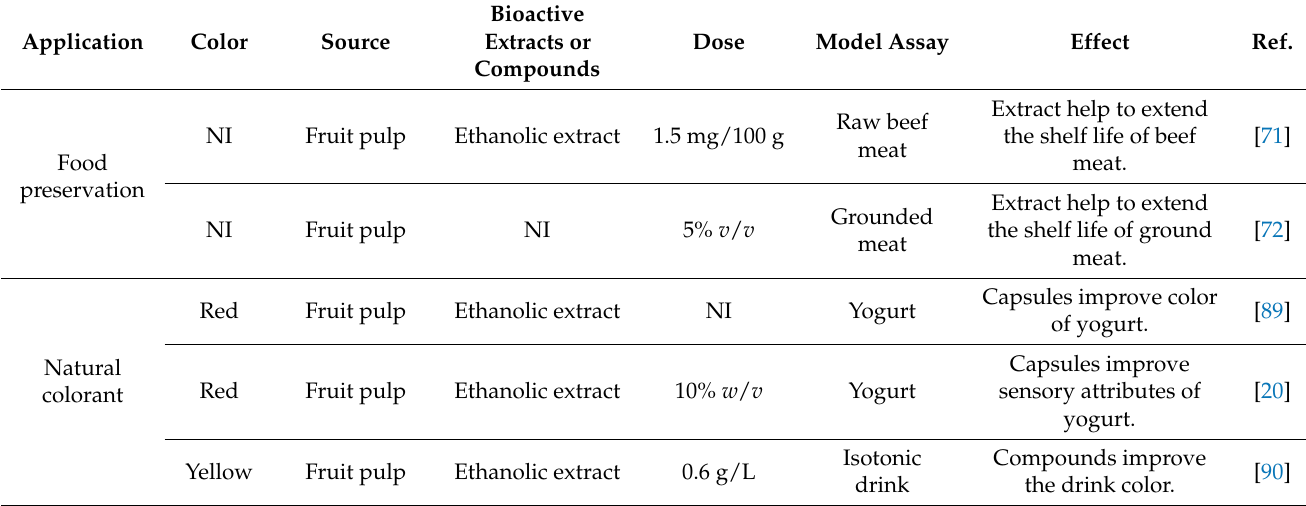
Table 8. Applications of bell pepper extracts in food